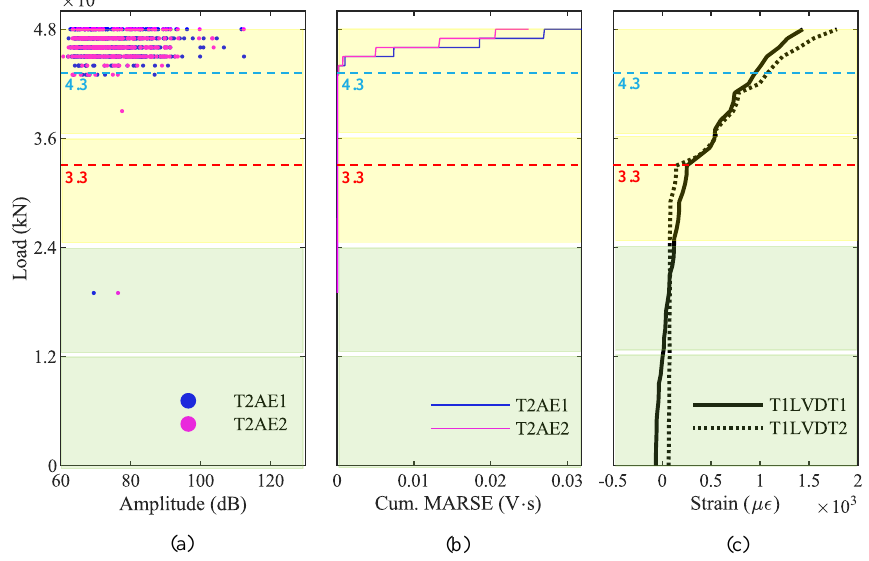
Figure 15. Results from AE and crack-opening sensors during phase P3: ( a ) amplitude from girder T2; ( b ) cumulative signal strength from girder T2; ( c ) longitudinal strain at the bottom of girder T1.